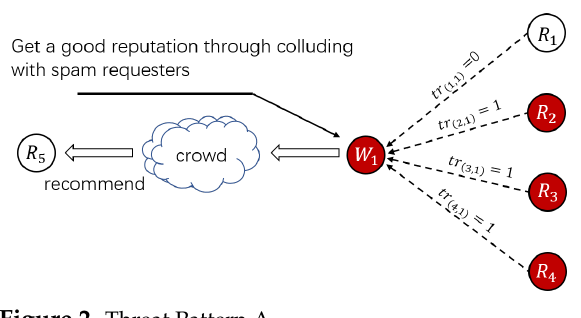
Figure 2. Threat Pattern A.